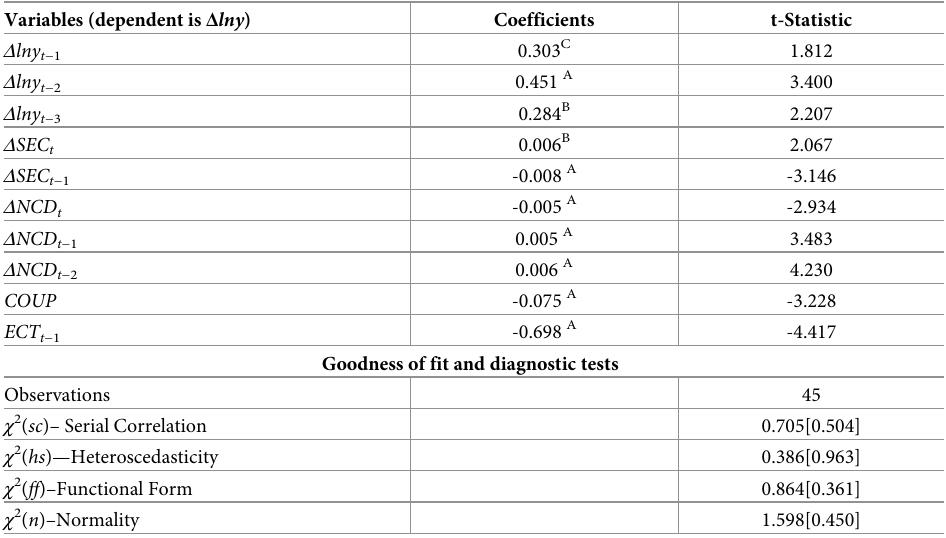
A, B, C indicate significance at 1, 5 and 10 percent levels. F-statistics represent diagnostic tests for serial correlation, heteroscedasticity and functional form while Jarque-Bera test statistic is shown for normality test. [] contains the p- values.